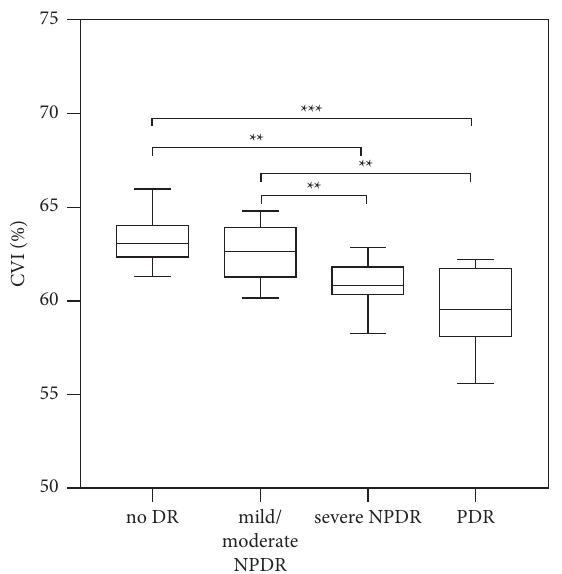
Figure 3: The CVI in different DR groups in 90 eyes of 45 patients with DN. CVI: choroidal vascularity index; DR: diabetic retinop- athy; NPDR: nonproliferative diabetic retinopathy; PDR: prolif- erative diabetic retinopathy; DN: diabetic nephropathy. ∗∗ p < 0 . 01 and ∗∗∗ p < 0 . 001.